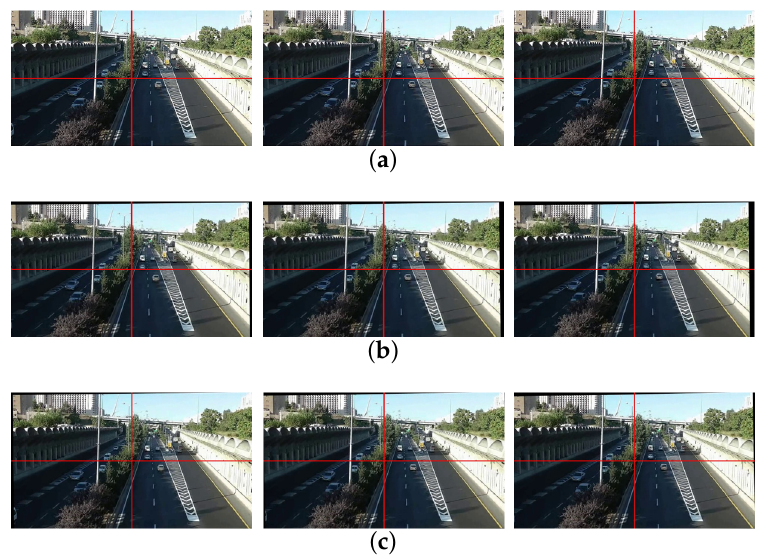
Figure 12. Experiment results of different video stabilization methods: ( a ) shaky video frames with multi-object motion (129th, 130th, and 131th frames), ( b ) the stabilized video of [10], ( c ) our method.